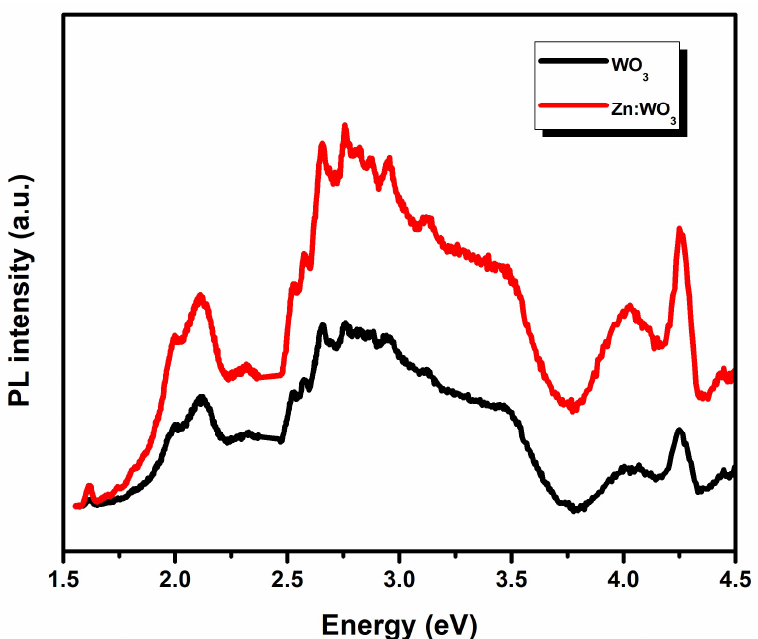
Figure 4. PL spectra of WO 3 and Zn: WO 3 films.